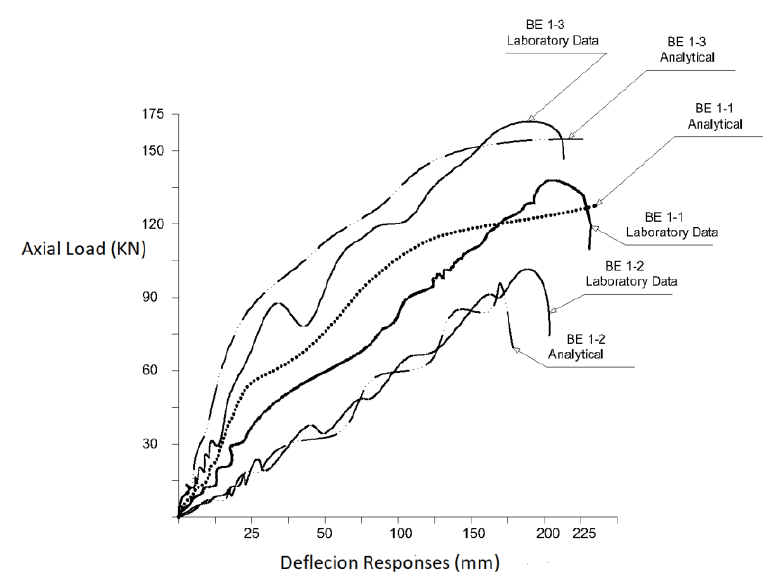
6 of 14 Figure 2. Instrumentation and beam test setup. The displacement of the beam at the midspan and the amount of the load application is recorded during the tests. The ultimate bending capacity for each beam is recorded. The results are shown as moment load in failure in the Table 1. The goal here was to measure responses of the geometrically identical beams reinforced with three different types of the GFRP tubes, as is shown in the Table 2.